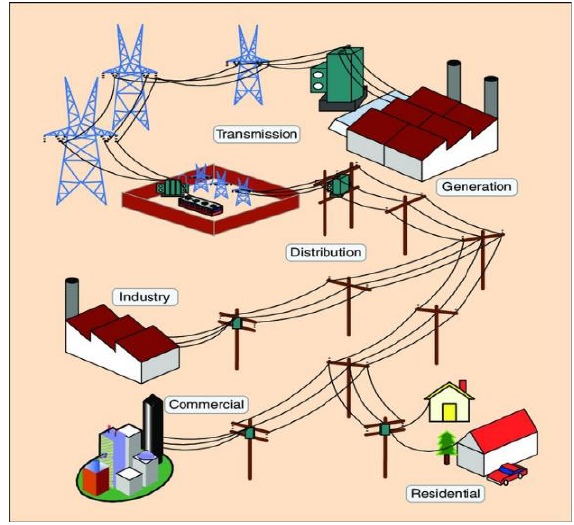
Figure 1. A traditional grid network system Adapted with permission from Ref. [9]. 2011, Xinghuo Yu.